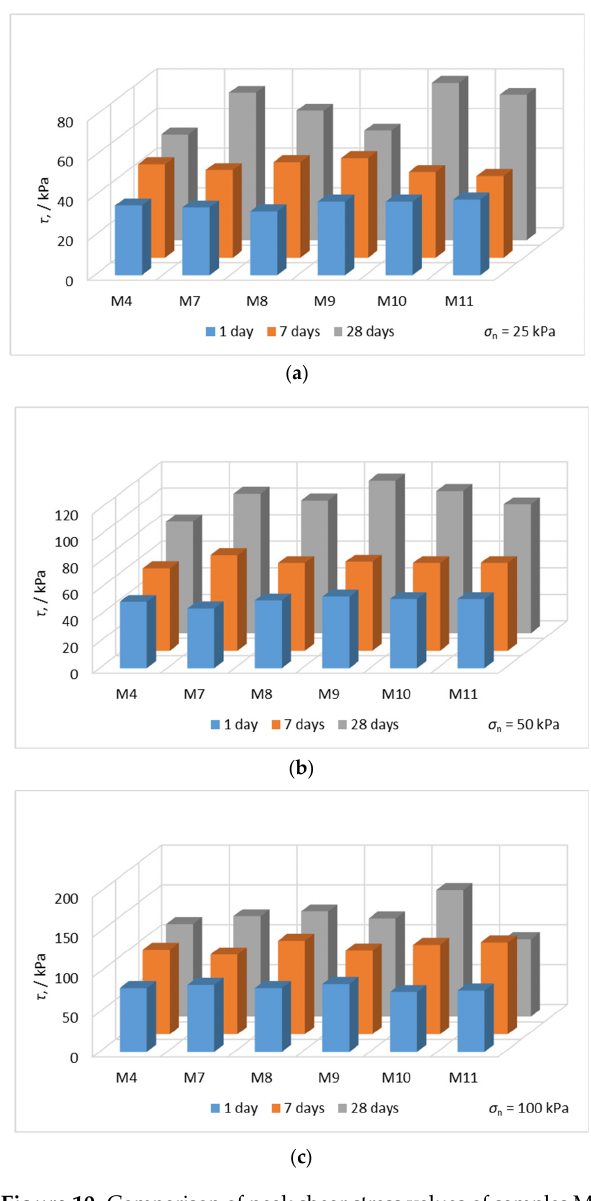
Figure 10. Comparison of peak shear stress values of samples M4 and M7–M11 (influence of natural fibers) for samples aged 1 day, 7 days and 28 days: ( a ) σ n = 25 kPa; ( b ) σ n = 50 kPa; ( c ) σ n = 100 kPa.